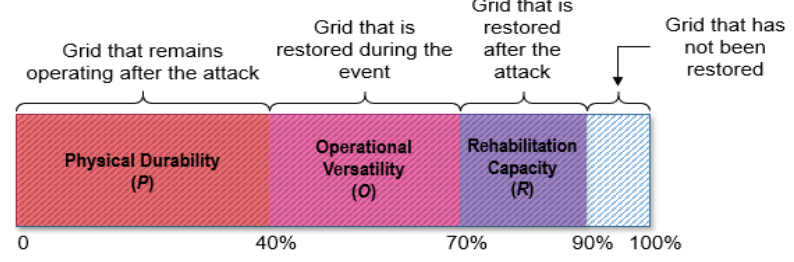
Figure 3. D eterminants of the grid capability. Figure 3. Determinants of the grid